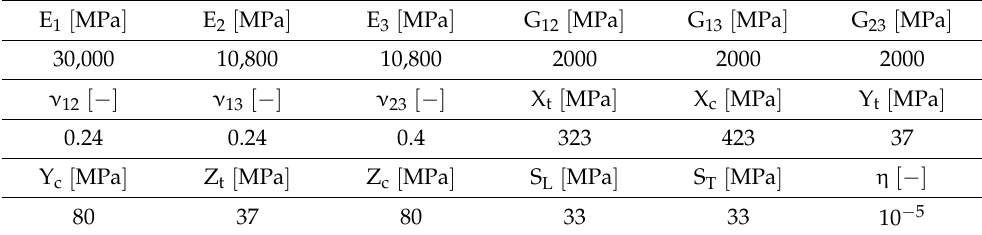
Table 3. Material properties for the pultruded GFRP material used in the three-point bending beam.